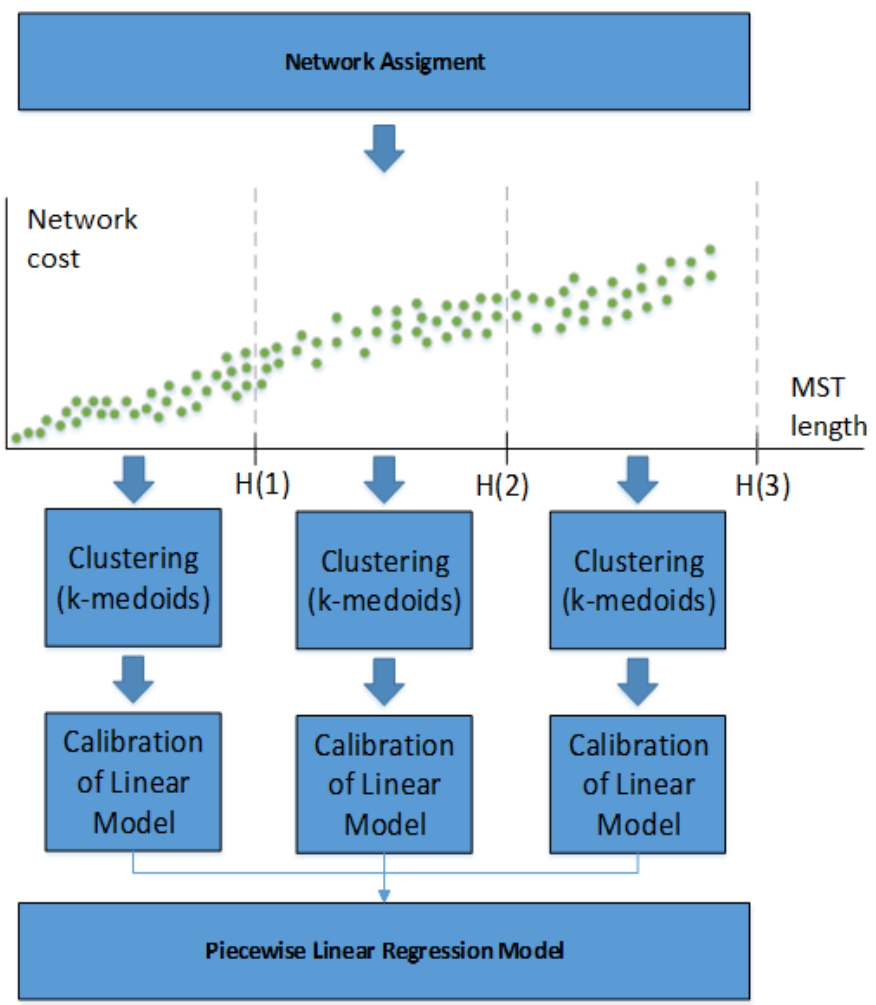
Figure 3. Flow diagram of the network cost estimation algorithm.